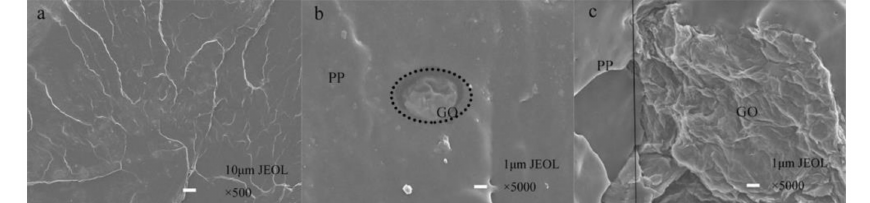
Figure 7. SEM image of low temperature fracture interface of PP, PP/GO blended fiber and PP/PP/GO composite fiber ( a ) pure PP fiber; ( b ) PP/GO blend fiber; ( c ) PP/MAH/GO-3 composite